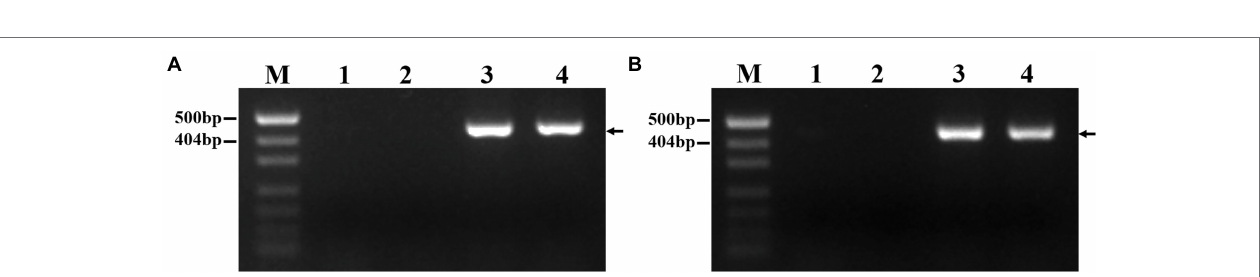
FIGURE 5 | Plant morphology of the wheat- P. huashanica ditelosomic addition line DT23 and its wheat parents. (A) Adult plants, (B) Spikes, and (C) Spikelets and grains. 1: CS; 2: CS ph2b ; 3: DT23.